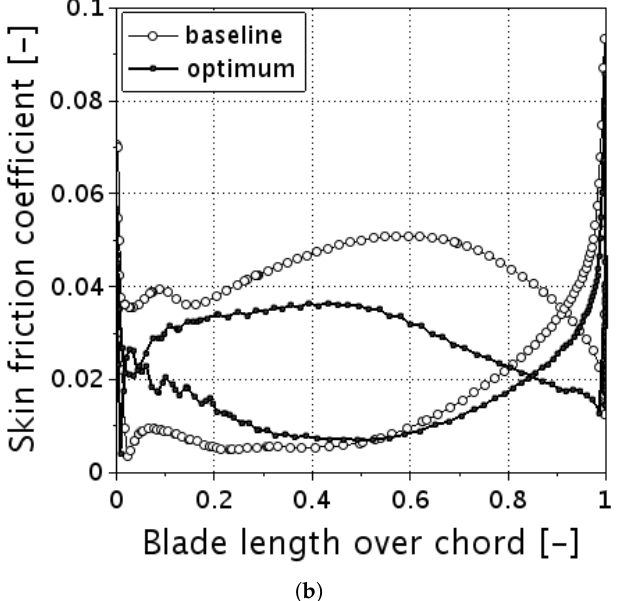
Figure 16. Pressure coefficient ( a ) and skin friction coefficient ( b ) along the blade for the baseline and the optimized geometry.